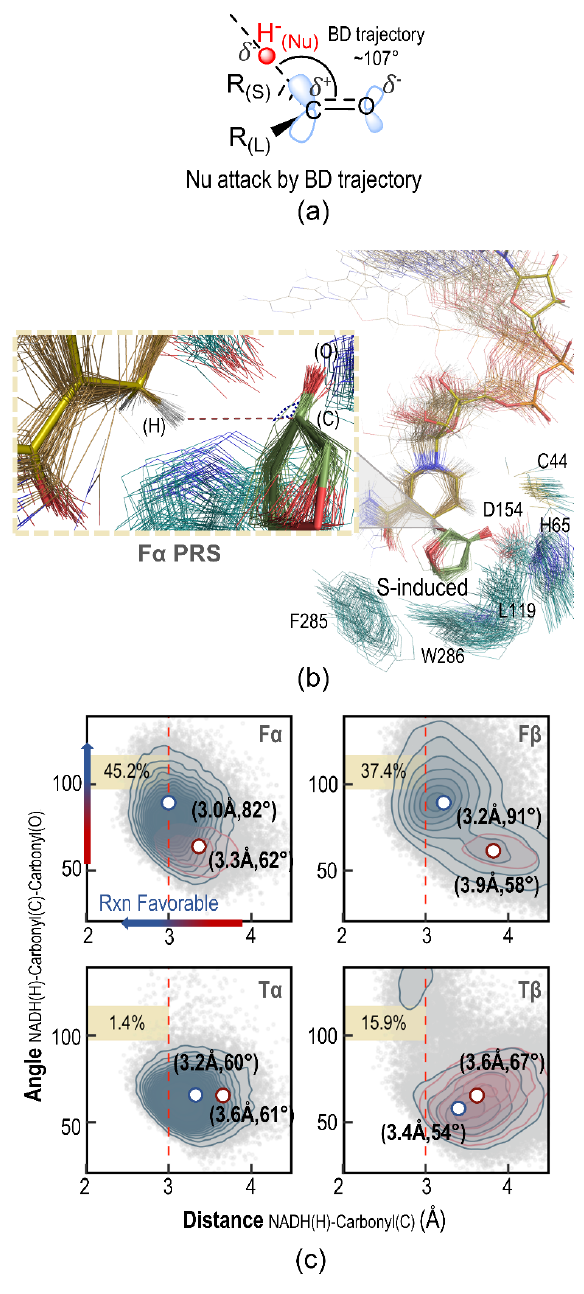
Figure 5. Pre-reaction state (PRS) analysis of the 5-m-r heterocyclic ketones bound in Cp RCR. ( a ) The frontier molecular orbital difination of PRS for the hydride transfer, where the nucleophilic hydride attacks the carbonyl carbon atom along the maximal orbital-overlapping direction known as the Bürgi-Dunitz (BD) angle. ( b ) The pro-S snapshots of F α in the MD simulations from the most reactive region of panel c (yellow box). The PRS parameters for the primary orbital interactions in the rate-determining step were defined as the distance between the coenzyme NADH C 4N -bearing hydride atom and the carbonyl carbon atom of ketones, plus the attacking angle of O=C---C 4N . ( c ) the PRS population of pro-S configuration in the F α , F β , T α , and T β . The values in the yellow areas are percentage of frames found with the optimal distance and angle for the hydride transfer. The background contour maps present the distributions of pro-S and pro-R conformations in the MD simulation, colored by blue and red,